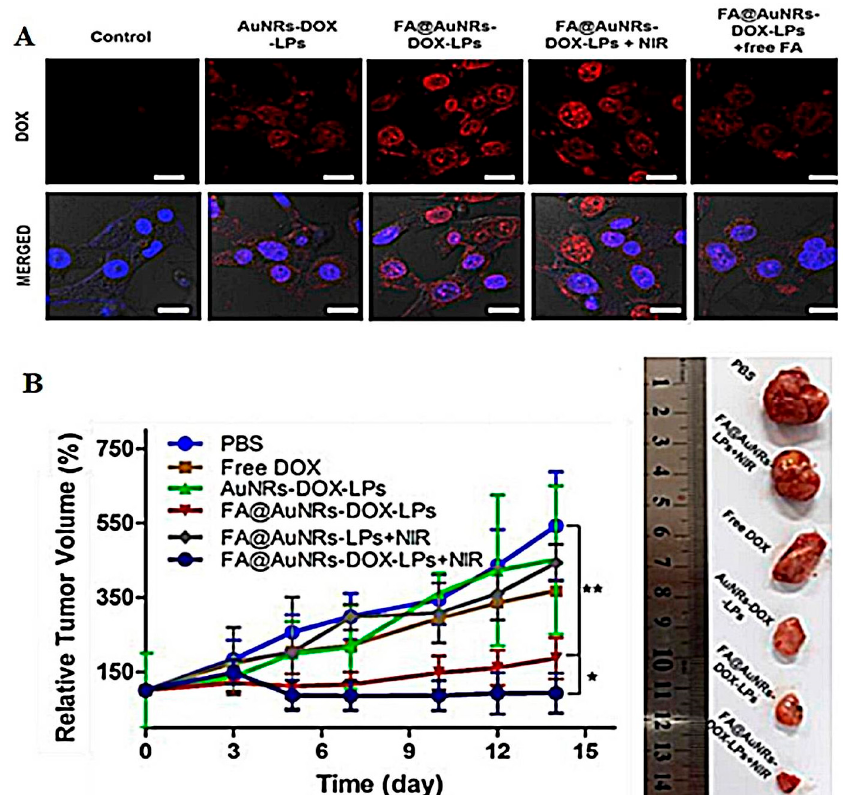
Figure 9. ( A ) Confocal laser scanning microscope images illustrated in vitro cellular uptake analysis of doxorubicin (represented by red signal) triggered by folic-acid-conjugated liposomal system. ( B ) Growth profiles and images of tumors of mice after gold nanorods liposomes nanocomplex injections. * p < 0.05; ** p < 0.01. This image was reproduced with permission from [94]. Copyright©, 2019, Elsevier.